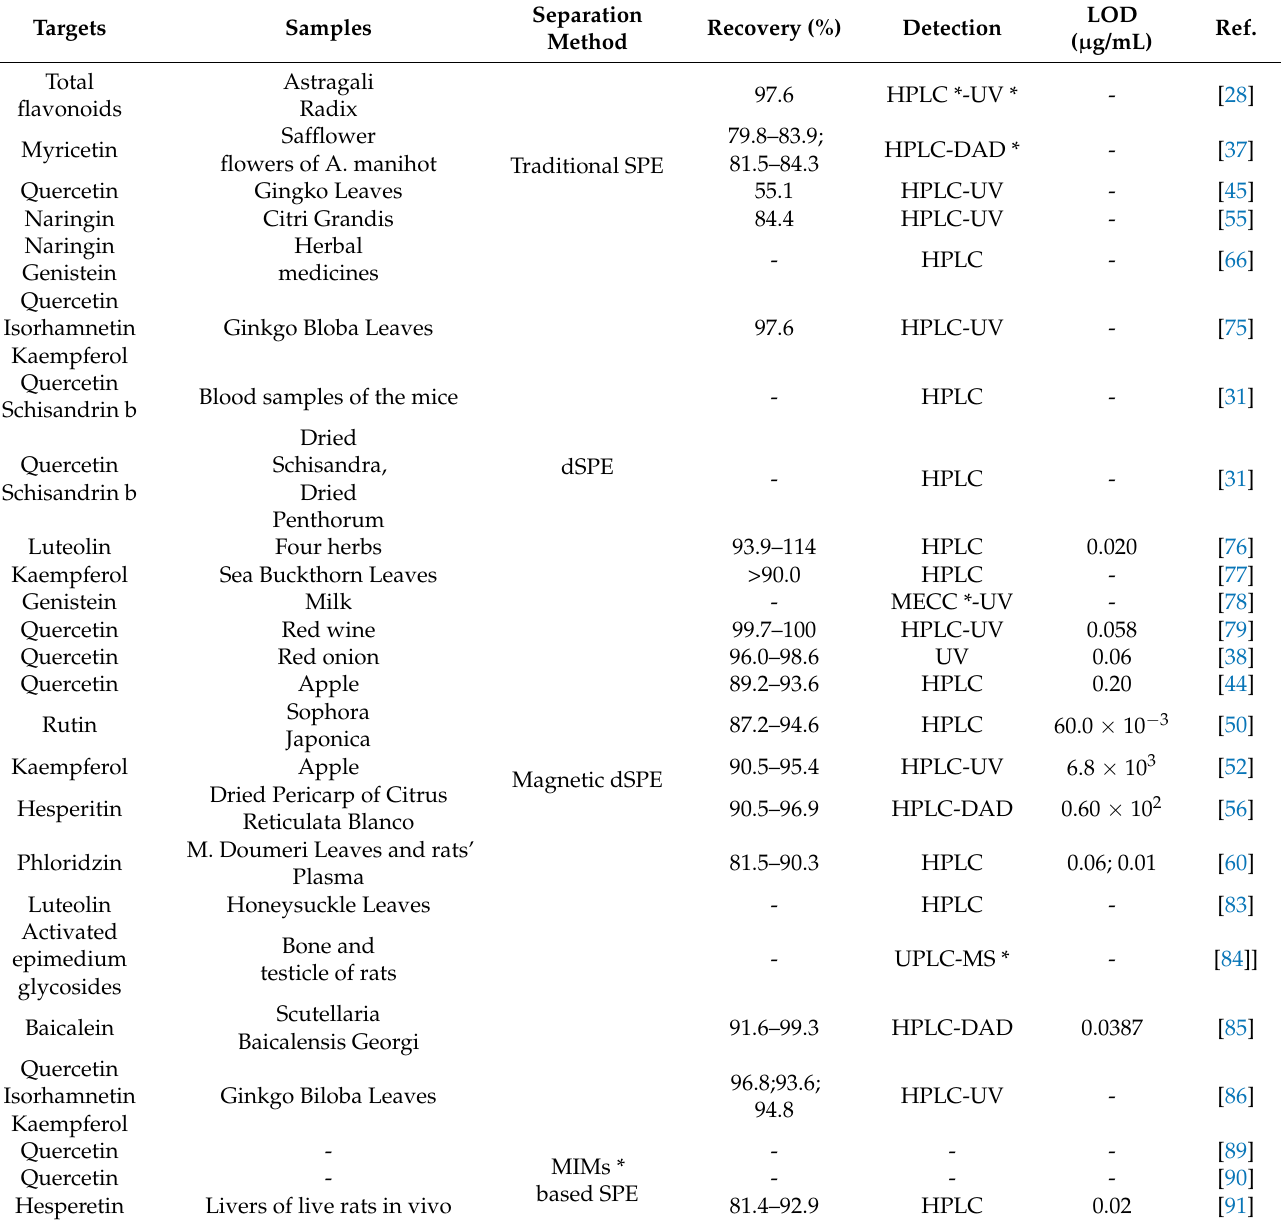
Table 2. Applications of MIPs based on SPE in